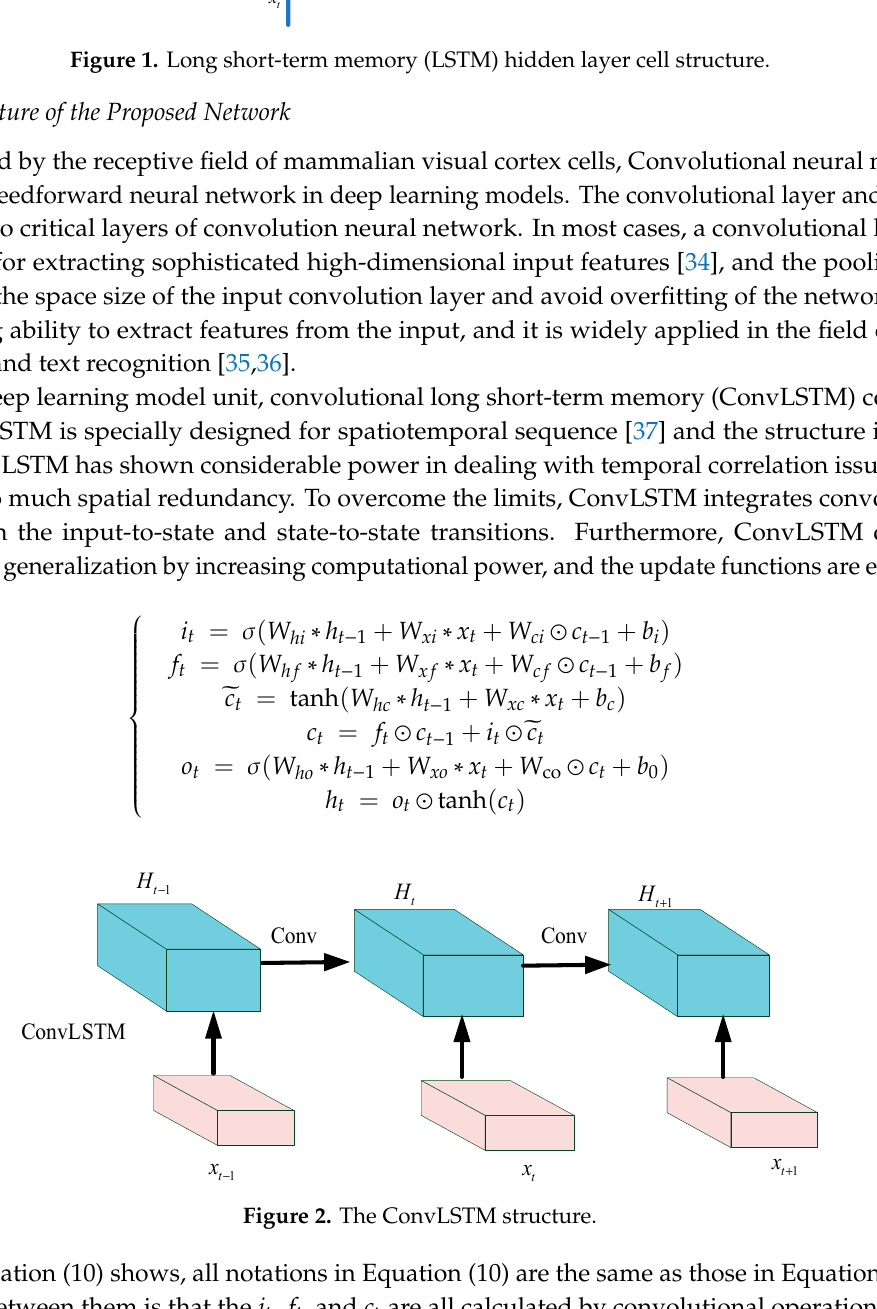
Figure 1. Long short-term memory (LSTM) hidden layer cell structure.